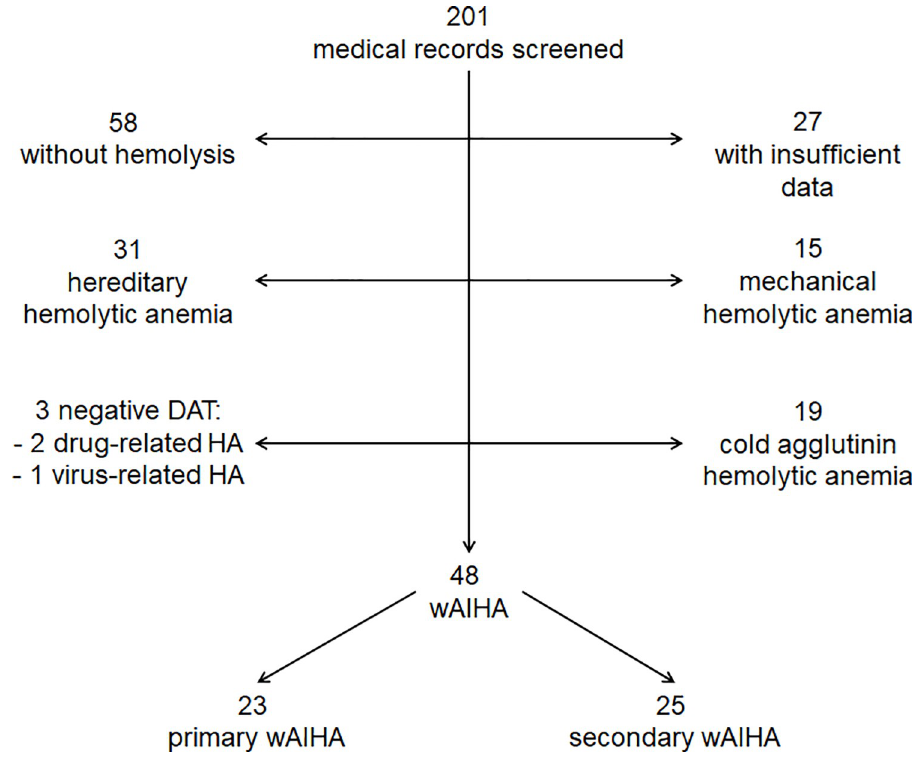
Fig 1. Flowchart of